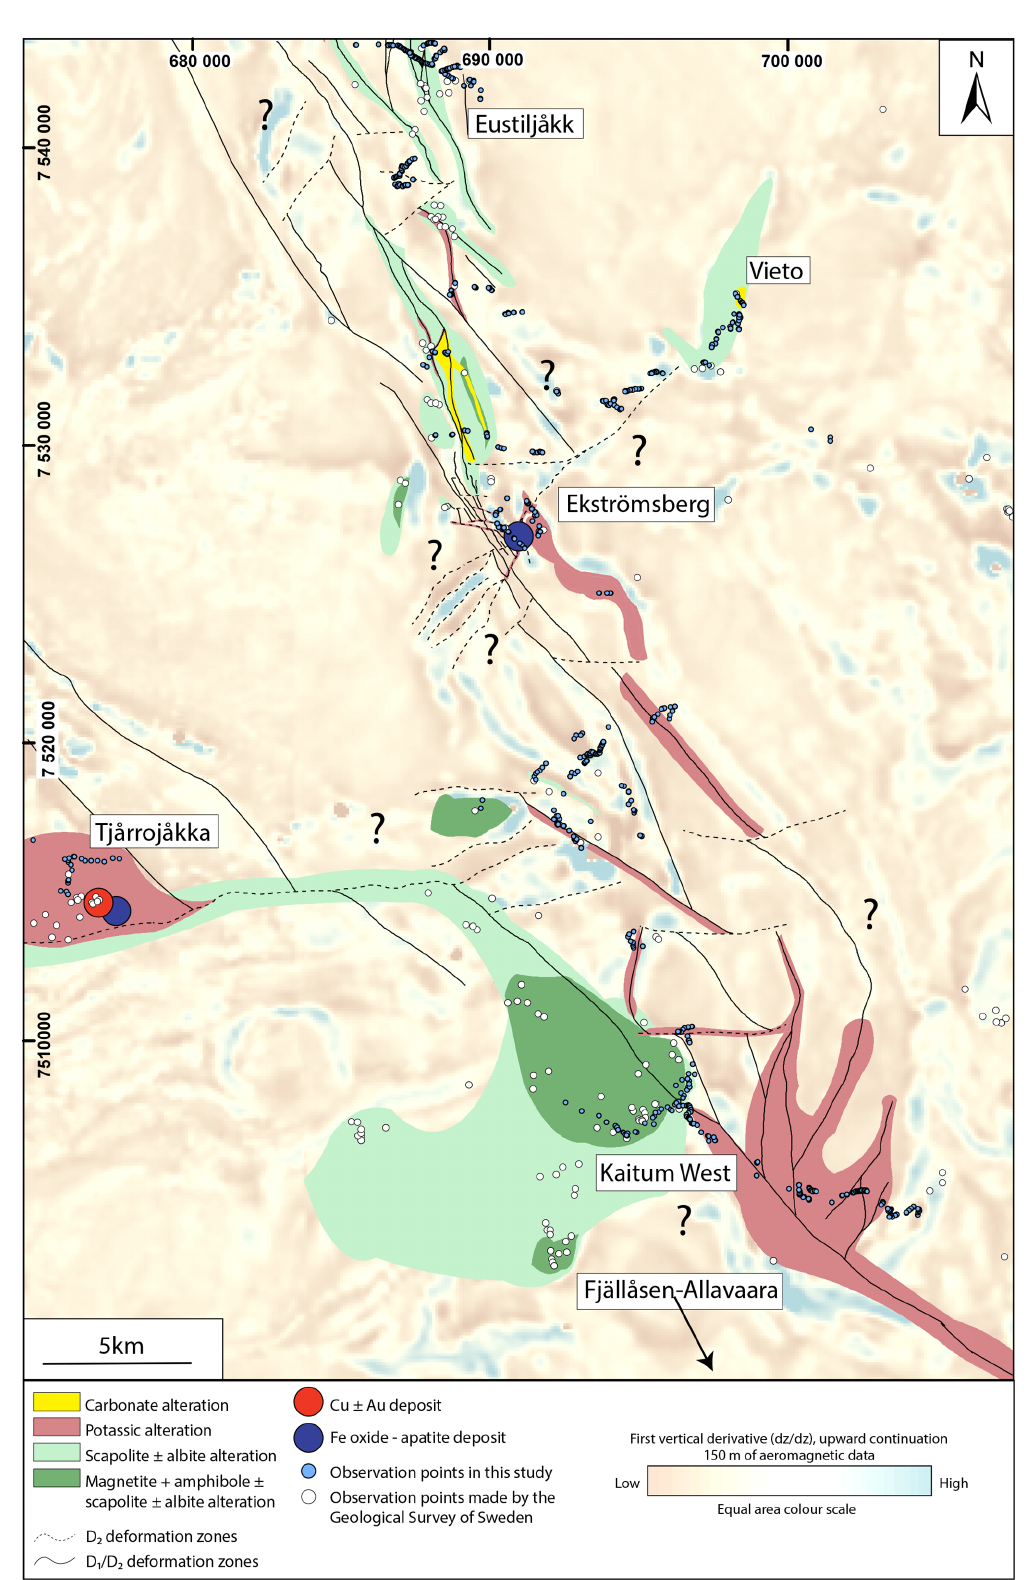
Figure 18. Geological map showing the spatial distribution of identified hydrothermal mineral associations and their relation to dominant structures and aeromagnetic anomalies. The map is based on the observations performed in this study together with a compiled database of recorded alteration minerals at the Geological Survey of Sweden. Coordinates in